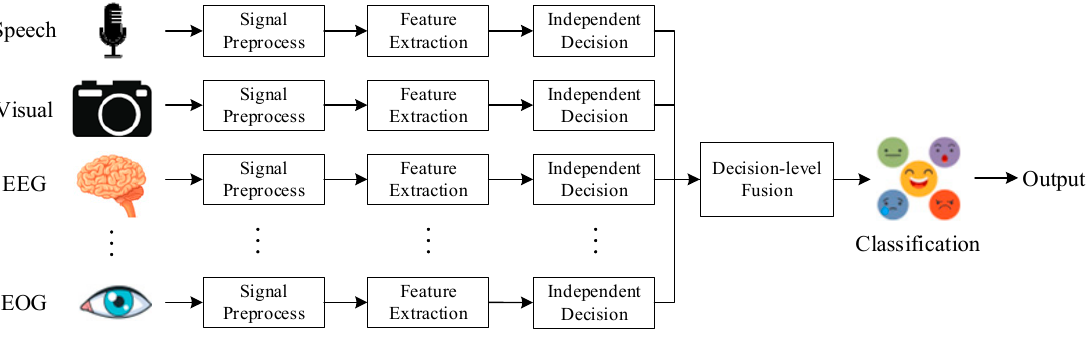
Figure 9. Decision-level fusion.